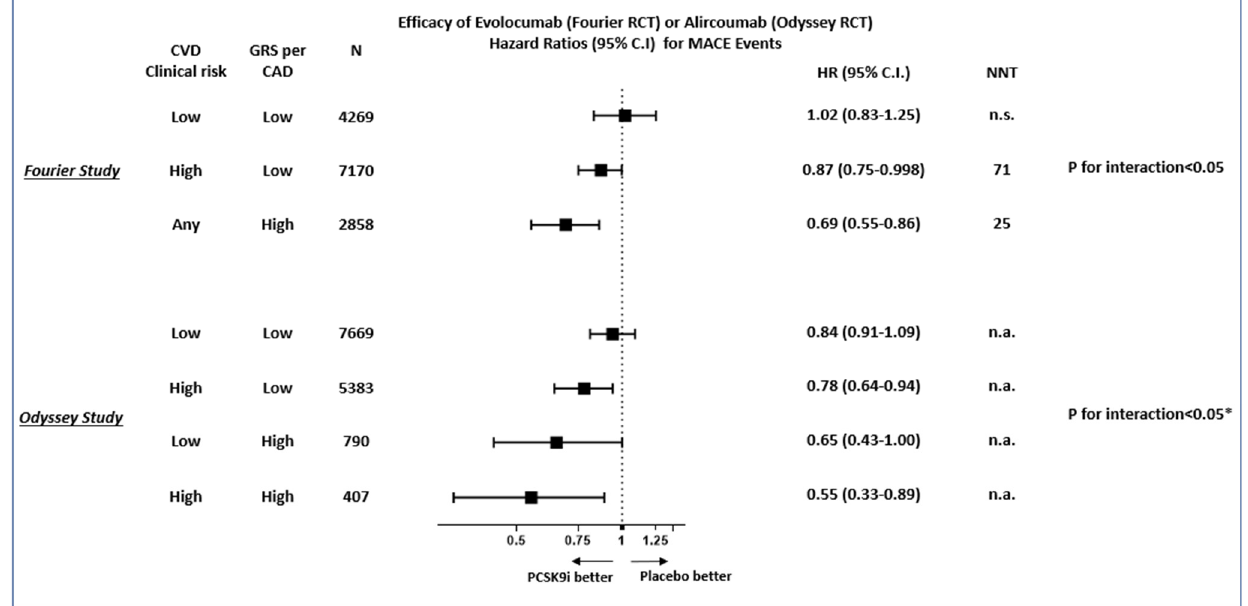
Figure 3. Efficacy of the PCSK9 inhibitors evolocumab and alirocumab in the FOURIER and ODYSSEY studies (patients in secondary cardiovascular prevention) stratified by the combination of clinical and genetic CVD risk information. Notes: in the FOURIER study, the clinical risk score is based on the presence of multiple risk factors, while in the ODYSSEY study this is exclusively on the basis of LDL cholesterol values > or < 100 mg / dl. NNT = number needed to treat over the study observation period (FOURIER 2.3 years) to prevent one MACE event. * In the ODYSSEY study, only the GRS × treatment interaction p was reported as significant, and the effect between efficacy of alirocumab in the low genetic and clinical risk group was significantly less than in the high genetic and clinical risk group (adapted from Damask et al., Circulation 2020 [23] and Marston et al. Circulation 2020